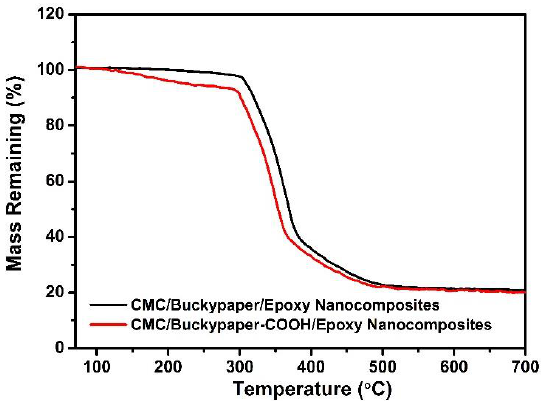
Figure 9. Typical TGA curves of unmodified and modified CMC/buckypaper/epoxy